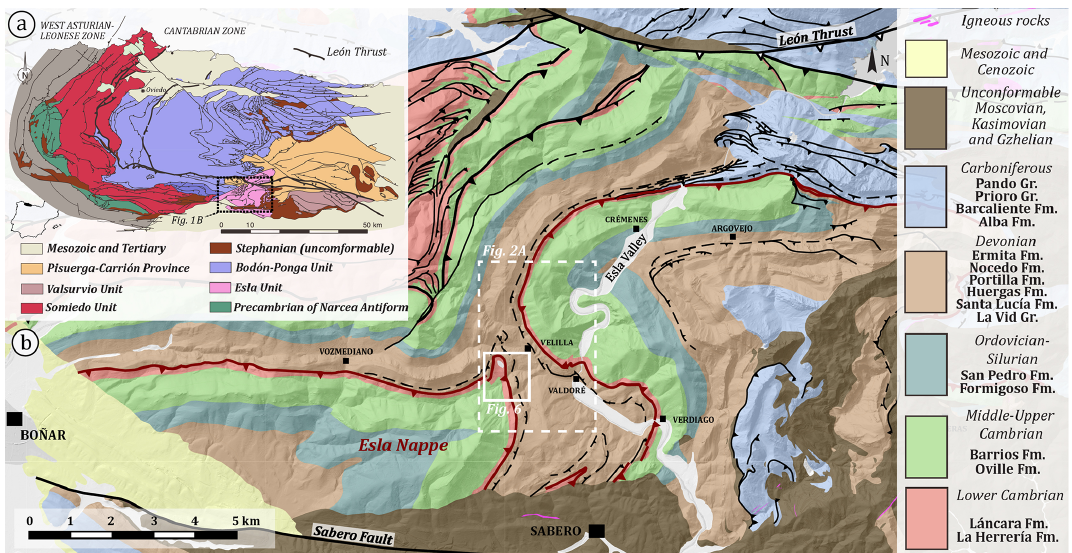
Figure 1. (a) Geological map of the Cantabrian Zone modified from Alonso et al. (2009). (b) Simplified geological map of the Esla Nappe modified from Merino-Tomé et al.